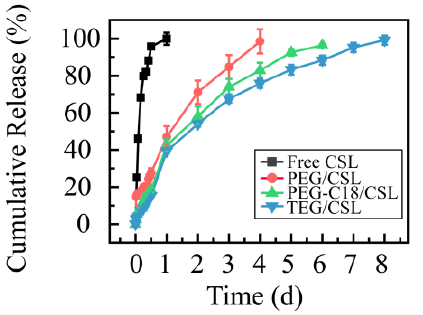
Figure 5. Cumulative release rates of CSL DMSO solution and CSL nanoparticles at 37 °C, n = 3.